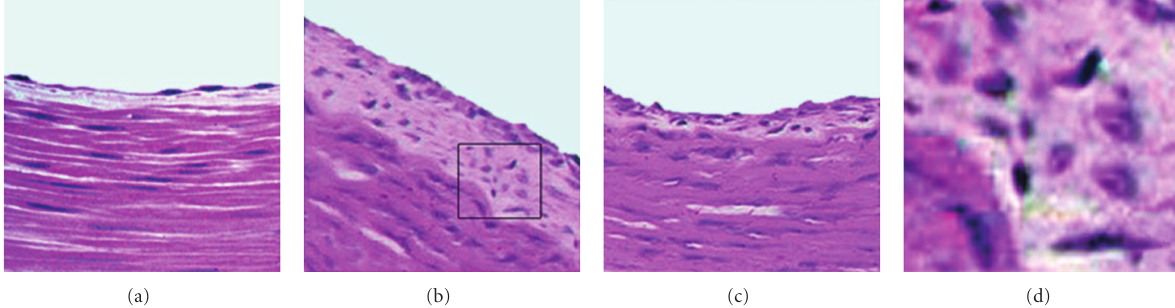
Figure 4: HE stained sections of the arterial grafts 2 months after transplant. (a) native carotid artery; (b) carotid arterial allograft (untreated control); (c) carotid arterial allograft (pretreated); (d) zoomed-in picture of the square fragment in Figure 4(b). Grafts in both DC-pretreated and control group showed di ff used and concentric intimal thickening compared with normal nontransplanted artery (a), which is the main feature of chronic allograft rejection. However, the intima was significantly thinner in the pretreated group (c) than that in the control group (b). Also we could see more lymphocytes infiltrated within control group allografts (d).